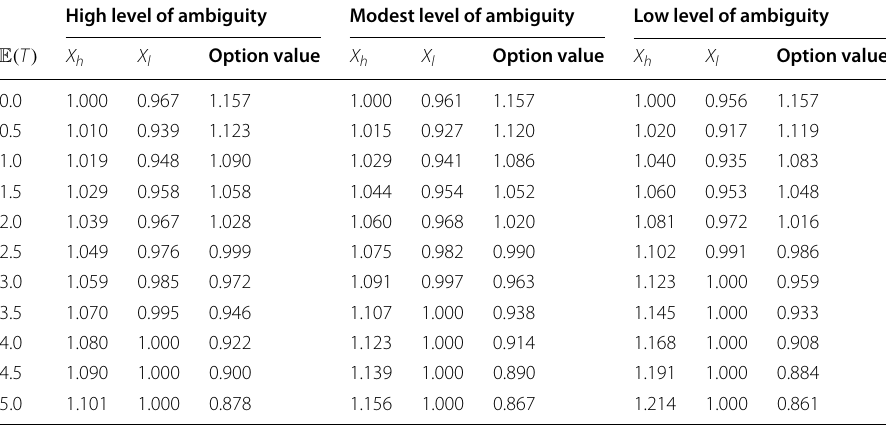
X h represents the threshold at which a future innovation arrives and this value corresponds to the expected time of its arrival. X l represents the optimal threshold at which managers invest optimally in the current innovation. “Option value” is the sum of the values of the options, F and G , given the values of X h and X l . “High,” “Modest,” and “Low” levels of ambiguity correspond to c = 0.2 , 0.3 , and 0.4 ,